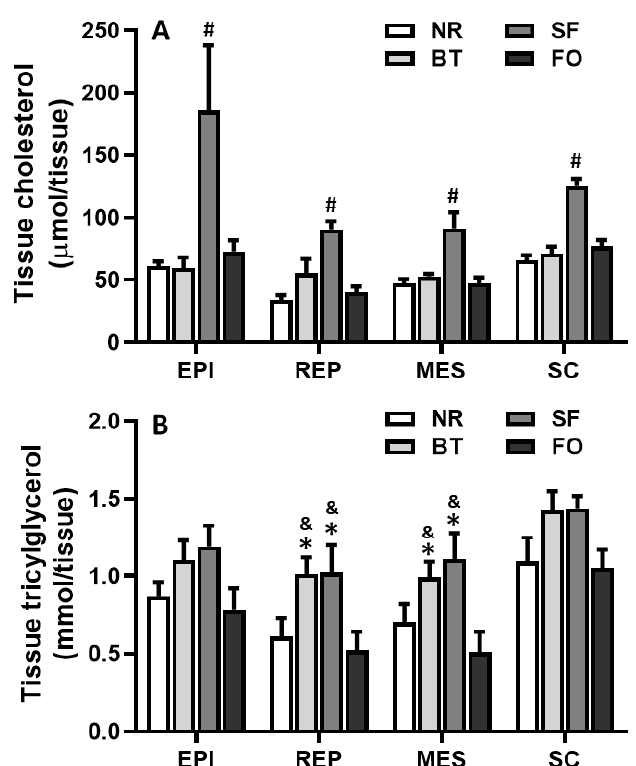
Figure 6. Comparison of cholesterol ( A ) and triacylglycerol ( B ) contents in the epididymal (EPI), retroperitoneal (REP), mesenteric (MES) and subcutaneous (SC) fat pads of rats after different diet feeding for 4 weeks. Values are expressed as mean ± SE.; n = 6, # p < 0.05, vs. the rest 3 groups; * p < 0.05, vs. normal rodent diet (NC); and & p < 0.05, vs. fish oil